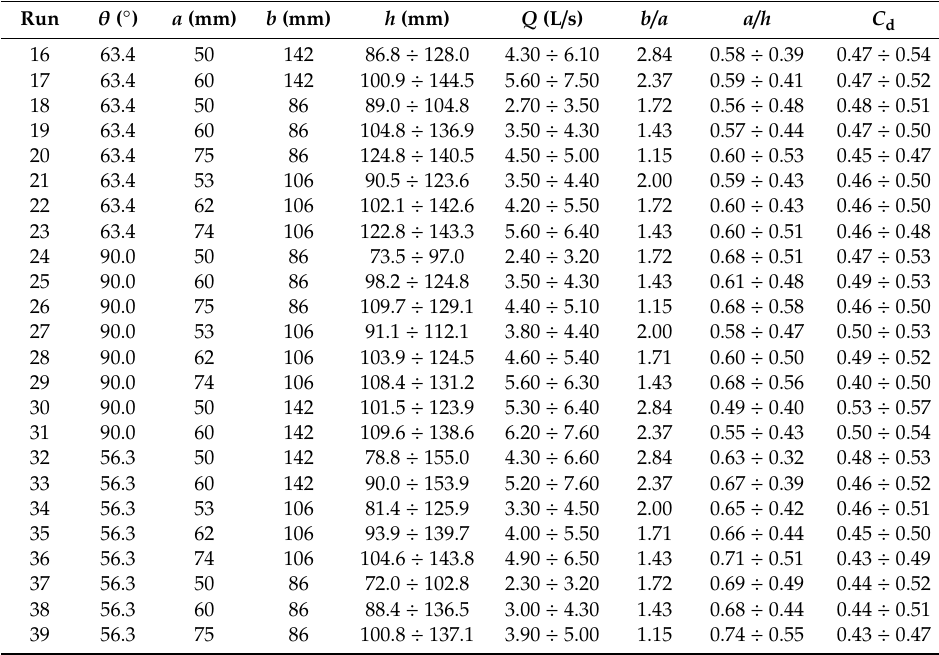
Table 2. Experimental data Series